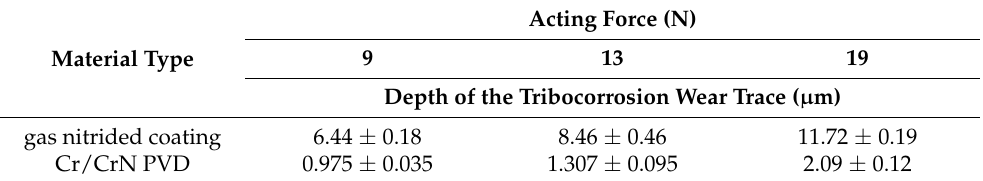
Table 4. Tribocorrosion wear of investigated materials related to different acting forces on the basis of the wear trace.